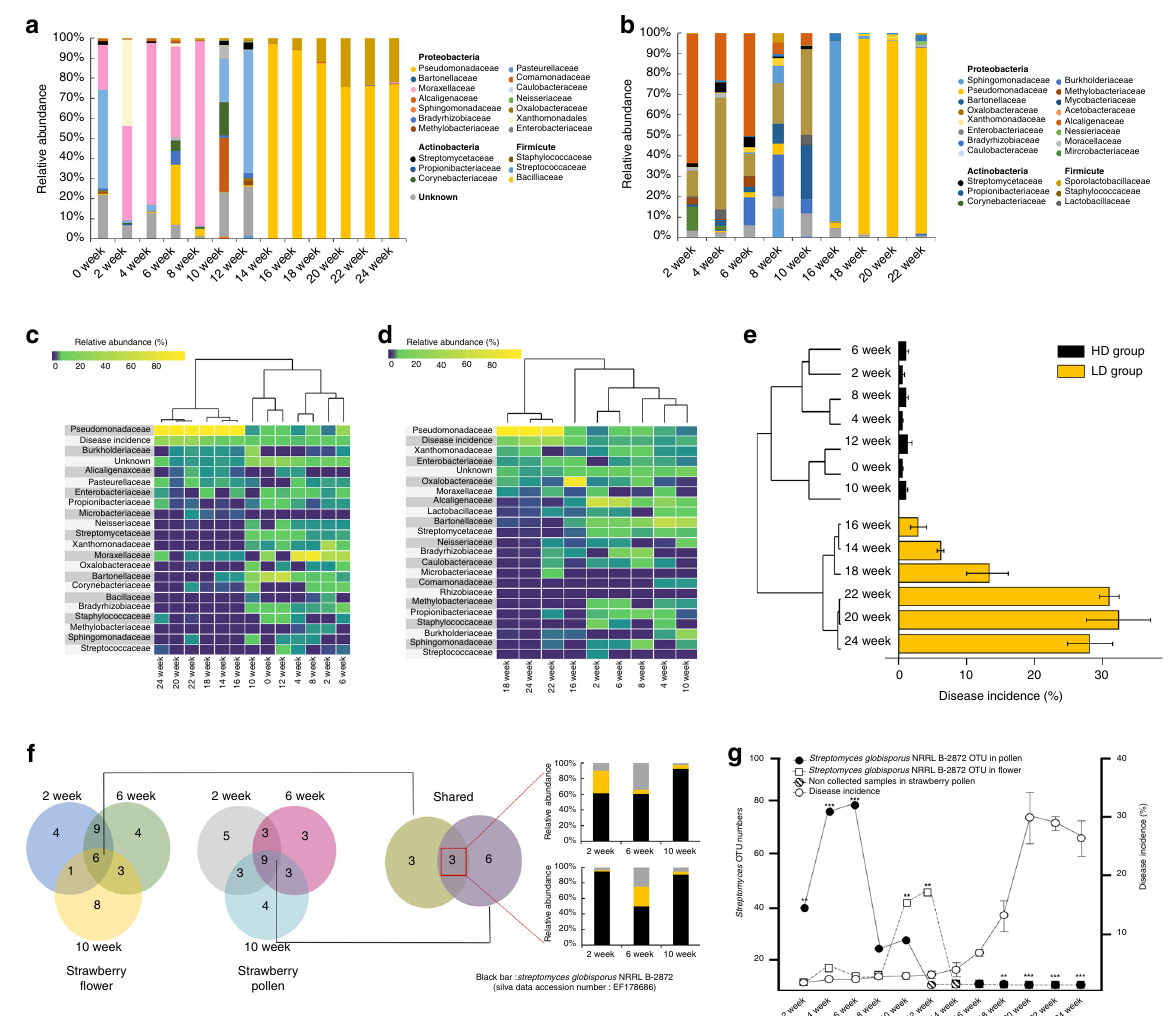
Fig. 1 Microbial diversity of strawberry fl owers and pollen. a Pyrosequencing of microbes in strawberry fl owers ( n = 9, 13 independent experiments) and b pollen ( n = 2, 9 independent experiments). Taxonomic assignment was conducted at the family level with the Silva database (http://www.arb-silva.de/) and a cutoff of 97% similarity. Flower and pollen samples were collected from November 2013 (0 week) to March 2014 (24 week). Heatmap of hierarchical clustering of bacterial communities by 16S rRNA region. c Flower samples and d pollen samples. Heatmap color (purple to yellow) displayed from low to high abundance of each OTU. e Beta diversity tree (Minkowski distance) of samples with gray mold disease incidence. f Venn diagram of common OTU numbers in fl ower and pollen samples during the period of low gray mold disease incidence. g Gray mold incidence over a growing season as related to Streptomyces OTU read numbers. Gray mold incidence, bars represent standard error of nine blocks, each block contains 150 plants. Star (*) indicates statistically signi fi cant differences between disease incidence and OTU numbers of Streptomyces globisporus NRRL B-2872, which is identical to SP6C4 and SF7B6 by t -test ( P value < 0.05). Bars represent standard error. a , b , e , f , g Source data are provided as a Source Data fi